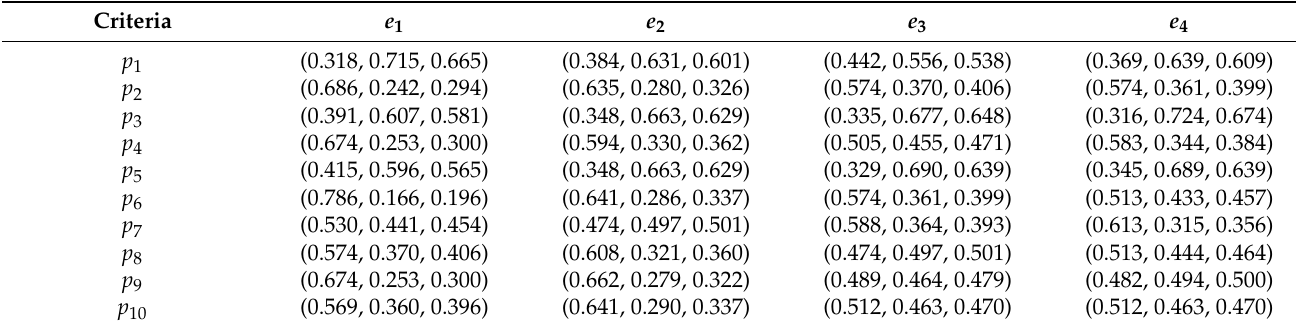
Table 7. Aggregated decision matrix for evaluating RESs.